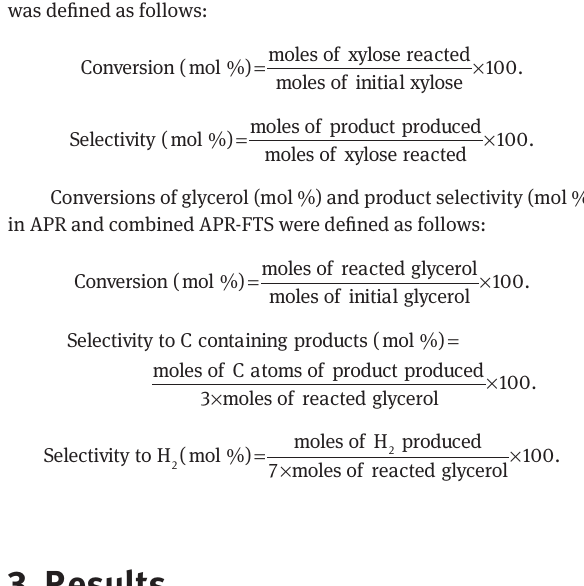
Figure 4: Distribution of the products during xylose dehydration and the combined process of xylose dehydration-hydrogenation (165 ° C , xylose 10 g, water 300 ml, solvent 300 ml, Amberlyst-15 10 g, Ru-C 0.4 g) at the conversion of xylose of about 70% (except test at 135 ° C with conversion